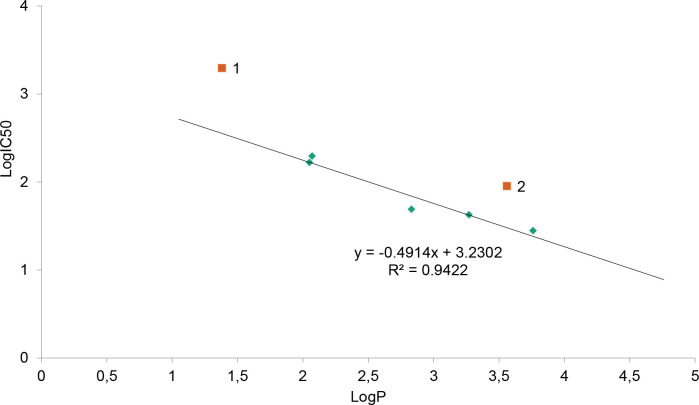
The toxicity on lipophilicity (ACD/LogP Classic) dependence of the described series of compounds.The two exceptions are chromone (1) and flavone (2).